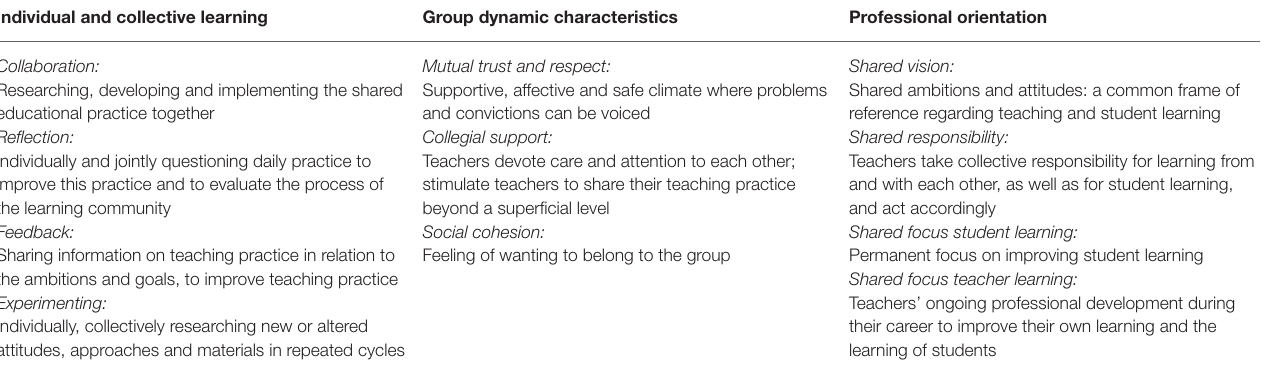
TABLE 1 | Professional learning community characteristics (based on Van Meeuwen et al., 2019). Individual and collective